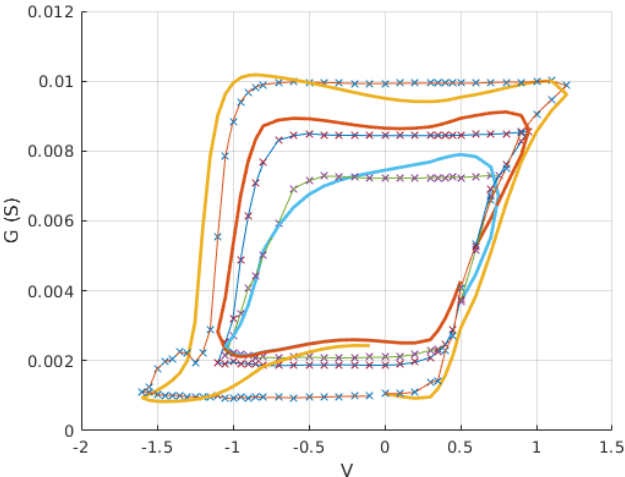
Figure 5. Results obtained using Equation (15) with the coefficients in Table 1 into Equation (13). Lines correspond to the model, while the crossed are the measured